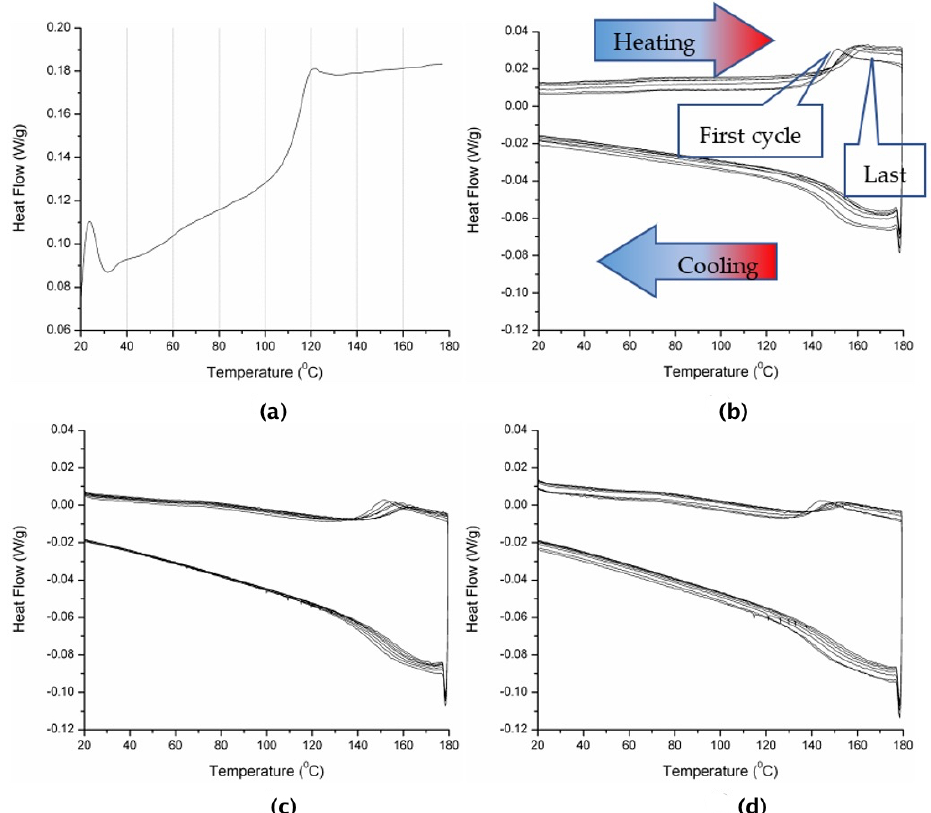
Figure 3. DSC measurements of ( a ) Tg of PE-fur. ( b ) PE-fur/Bism-2:1. ( c ) PE-fur/Bism-4:1. ( d ) PE-fur/Bism-8:1.